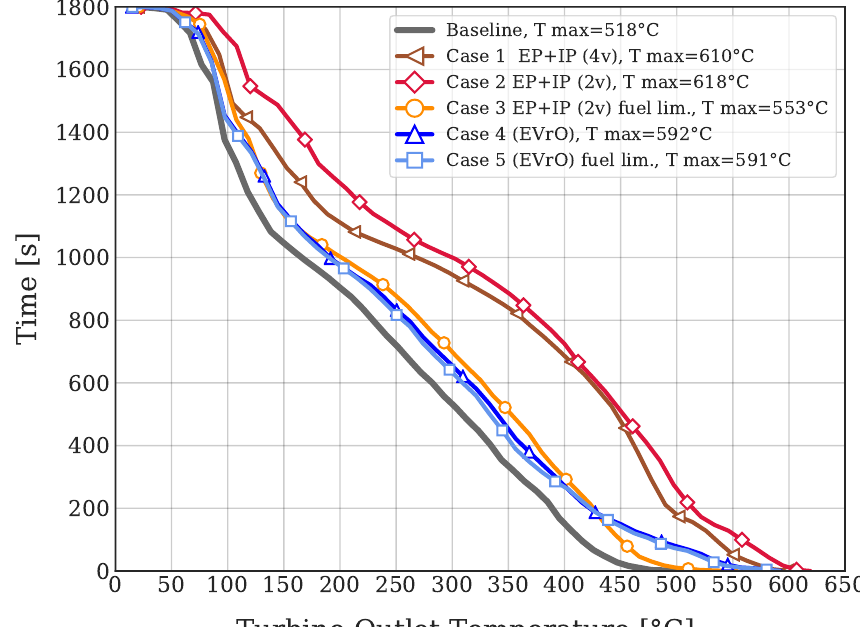
Figure 10. Time above a certain temperature at turbine